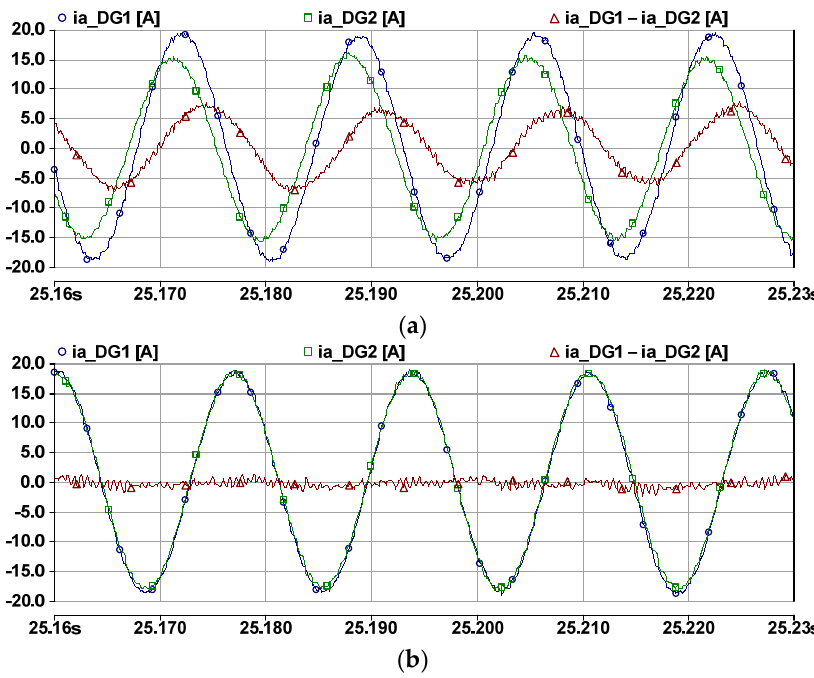
Figure 17. Simulation results of DG currents and circulating current: ( a ) Existing droop ( b ) Proposed droop.